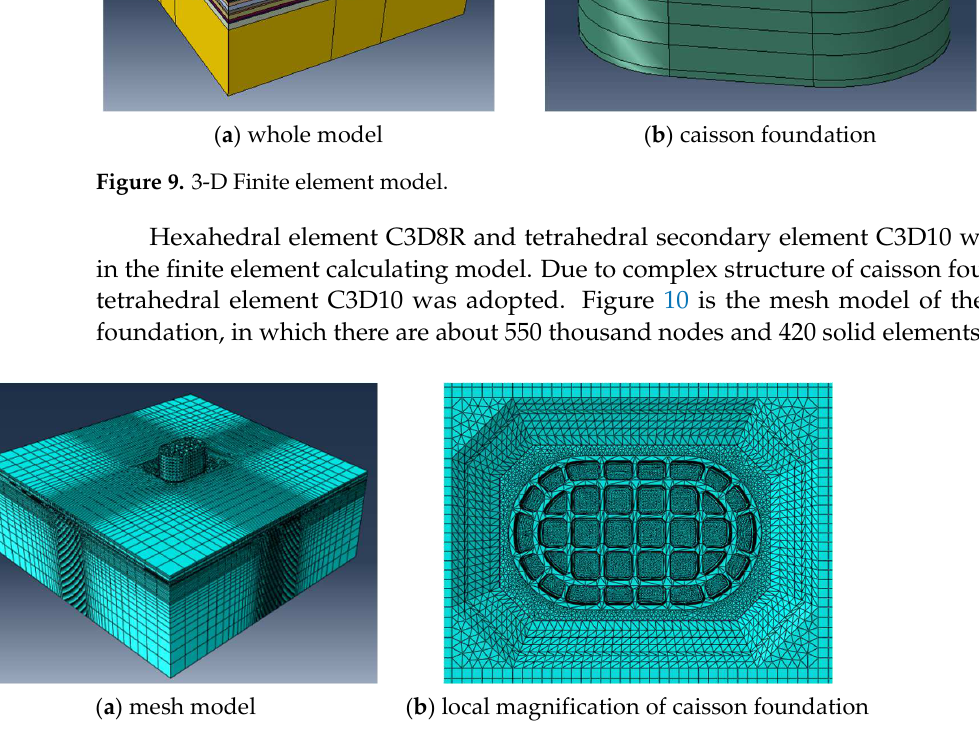
Figure 10. Finite element mesh model.